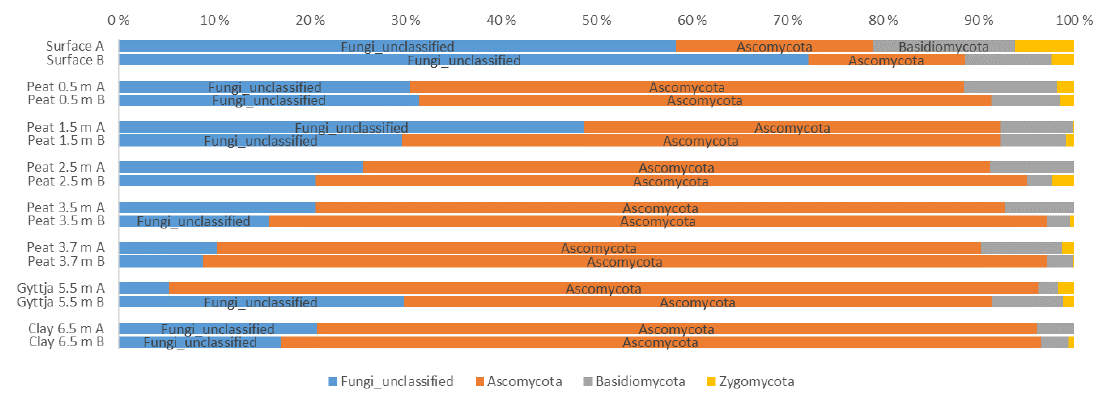
Figure 4. Relative distribution of fungal phyla in surface moss, peat, gyttja, and clay samples collected from Lastensuo bog. Each depth is represented by duplicate samples A and